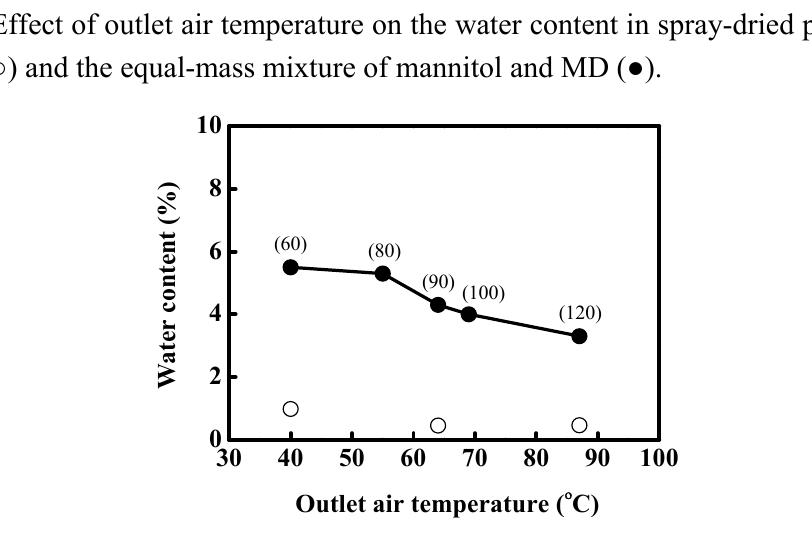
Figure 3. Crystallized particles of mannitol at the outlet air temperature at ( a ) 40 °C and ( b ) 66 °C.